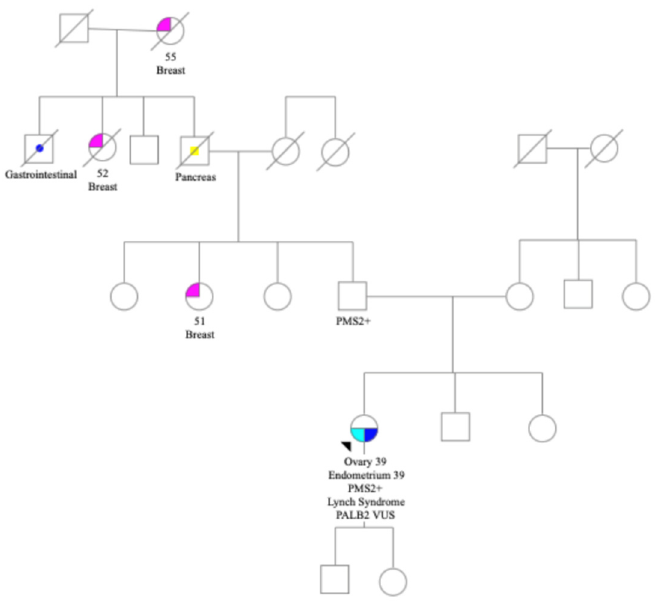
Figure 1. Patient pedigree illustrating family history of cancer. Patient underwent germline testing at Ambry Genetics lab with a 34 gene CancerNext +RNAinsight ® panel, identifying a likely pathogenic PMS2 mutation and a PALB2